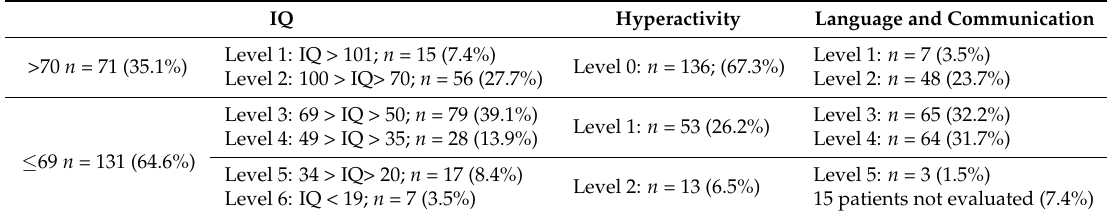
Table 5. Cognitive and behavioral characteristics of autistic patients.